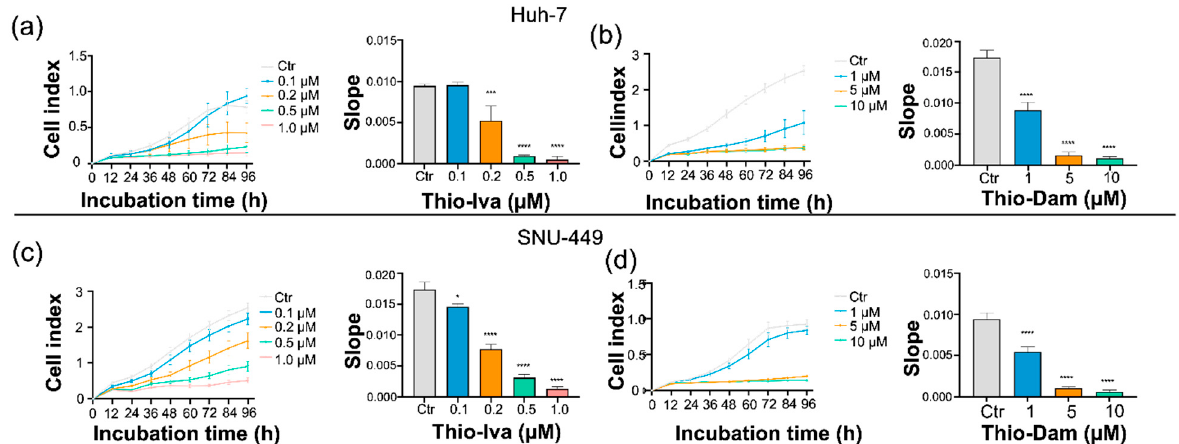
Figure 3. Real-time proliferation detection by iCELLigence. Dose-dependent effects of Thio-Iva and Thio-Dam on the cell index (CI) and its slope over time in Huh-7 ( a , b ) and SNU-449 cells ( c , d ). Statistical significance * p < 0.05, *** p < 0.001, and **** p < 0.0001 by ordinary one-way ANOVA as compared to untreated control. All results were expressed as means ± SEM of 3 independent